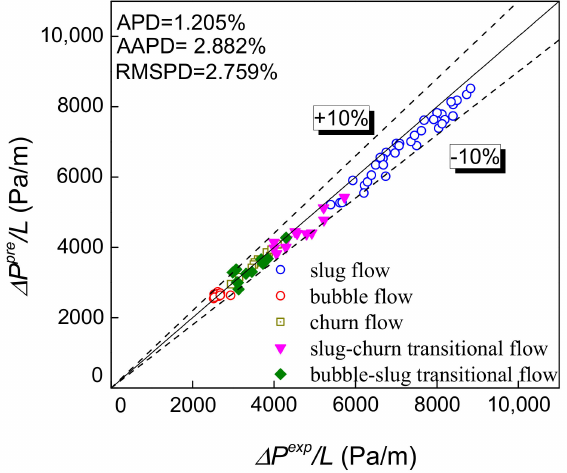
Figure 14. Pressure drop prediction of Zhang et al. model modified by using mixture friction